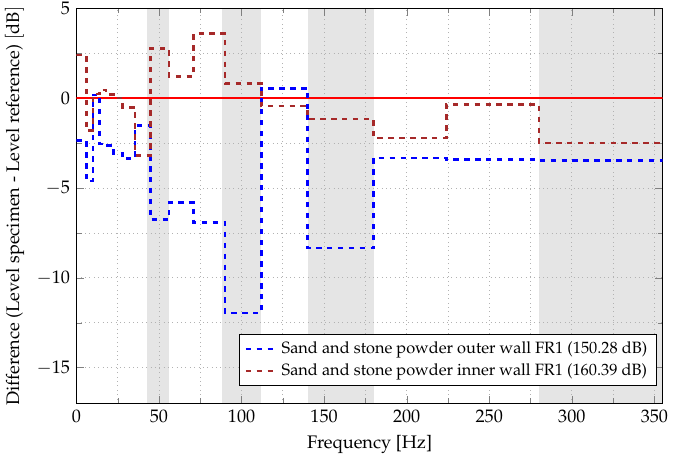
Figure 9. Difference in one-third octave band: FRF of MU HCDP mounted to the outer wall of the stator ring, opposite to the excitation point. Sum level of surface velocity is given in dB. reduction is mainly coming due to the particle damping mechanism and not only because of mass, see Figure A3 - Figure A5. The influence of empty HCDP for each SU HCDP configuration at a different location on the WTS test specimen is investigated because its response on FRF is dependent on mounting position. From the above discussion, it can be concluded that the presented configuration shows a significant reduction in vibration amplitude for the resonance peaks near 50 Hz, 150 Hz, and 355 Hz. It has been also observed that stone powder and sand show the maximum vibration reduction near first